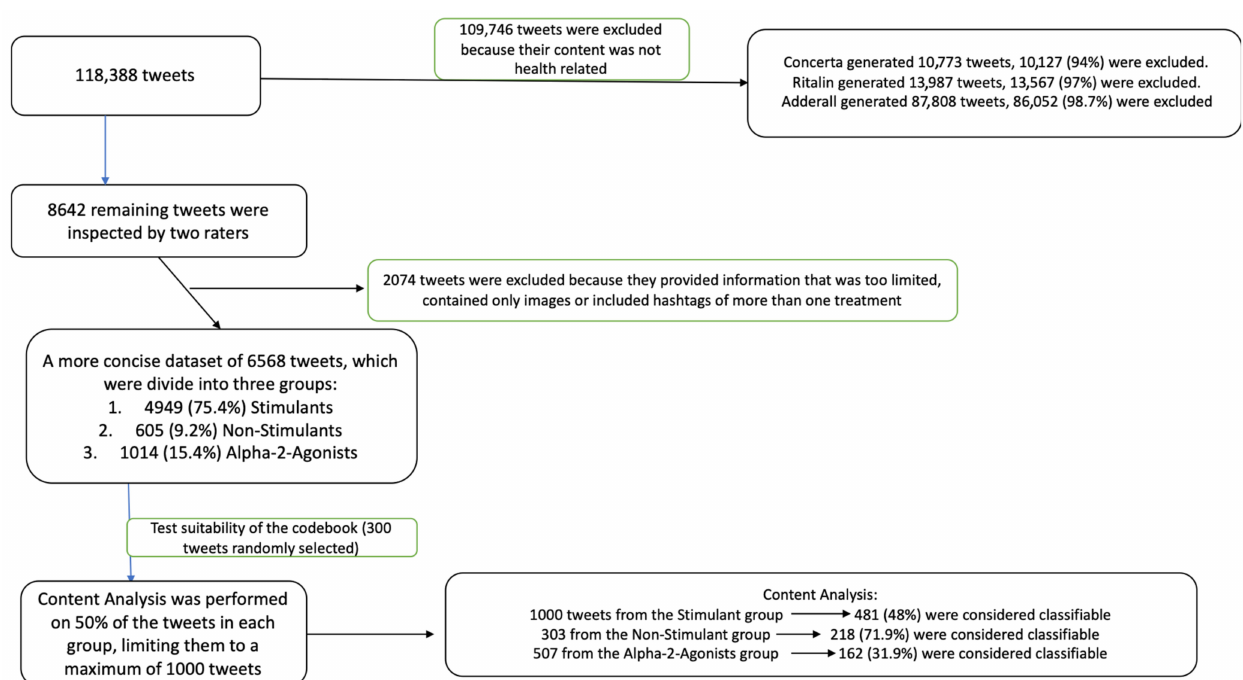
Figure 1. Flowchart of data